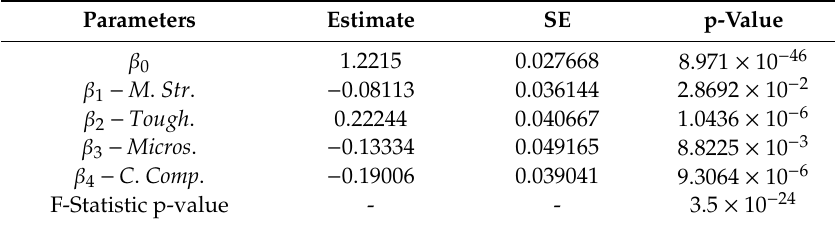
Table 5. Cross-validation results.